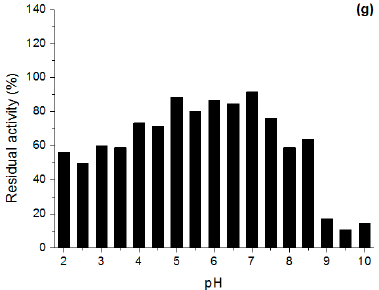
Figure 1. Stability in different pH of the Penicillium sp. (CBMAI 1583) lipase derivatives in aqueous media. ( a ) Butyl Sepharose; ( b ) phenyl Sepharose; ( c ) octyl Sepharose; ( d ) Toyopearl butyl 650 M; ( e ) Lewatit VP OC 1600; ( f ) octadecyl Sepabeads and ( g ) CNBr derivatives. The derivatives were incubated at 1:10 ( w / v ) proportion in the following buffers: 0.5 M glycine-HCl pH 2.0 and 2.5; McIlvaine pH 3.0–8.0; 0.5 M Tris-HCl pH 8.5 and 9.0; and 0.5 M glycine-NaOH pH 9.5 and 10.0; for 24 h at 25 °C.